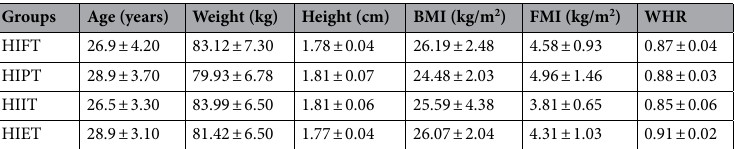
Table 1. Anthropometric characteristics of volunteers before the experiment. Data are presented as mean ± SD. BMI body mass index; FMI fat mass index; WHR waist to hip ratio.